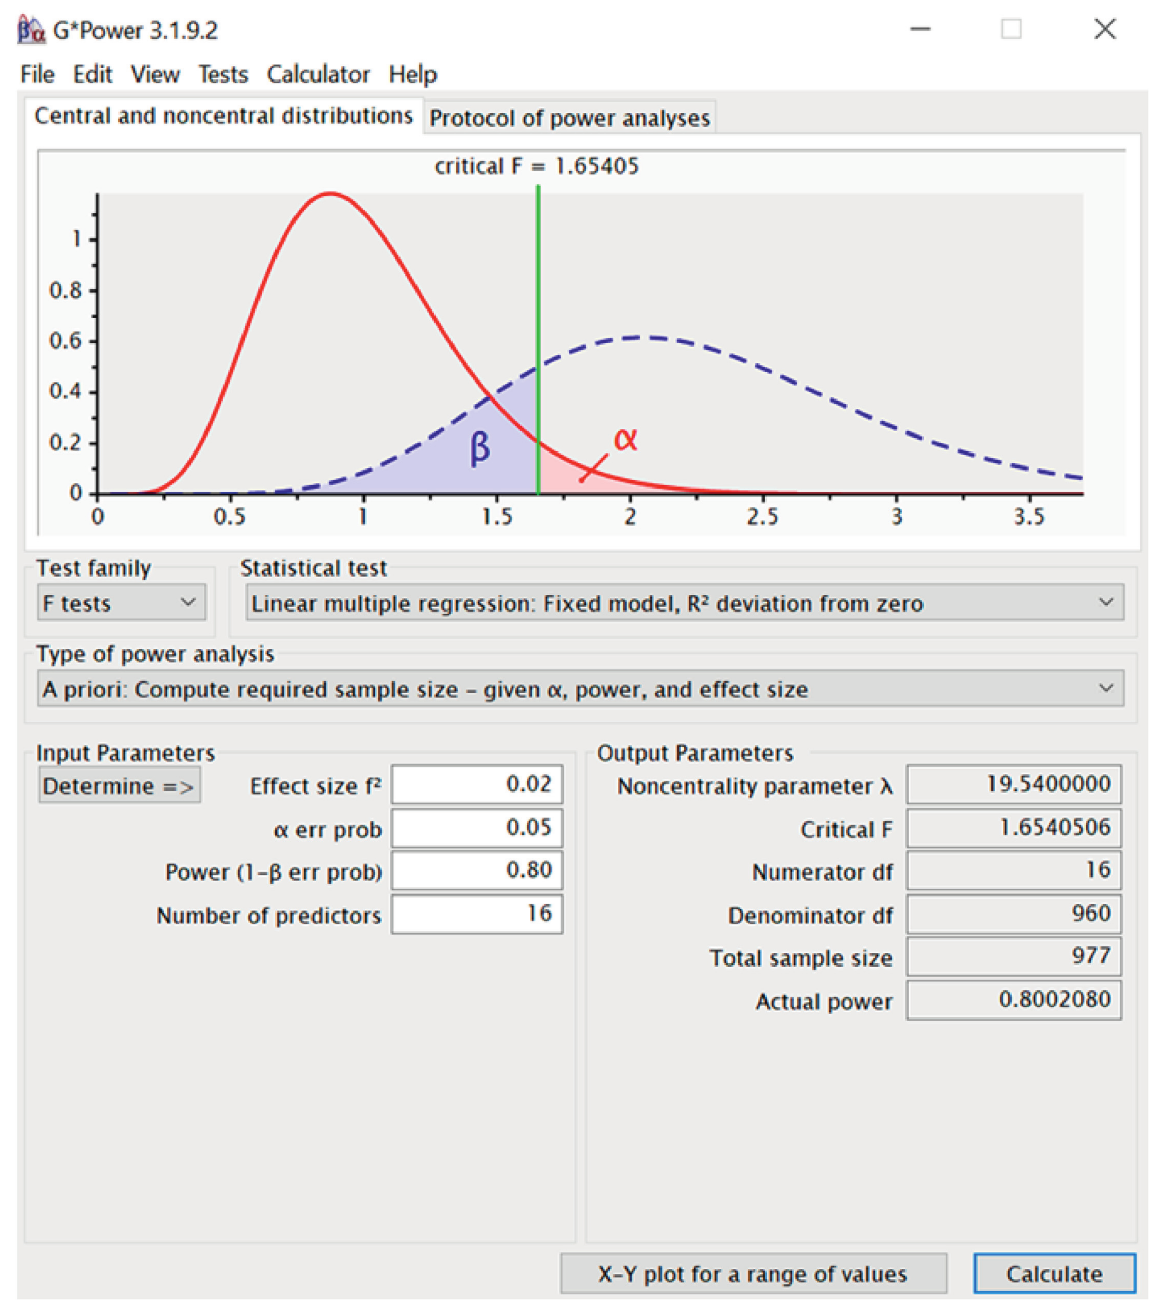
Figure 1: Sample size calculation using G ∗ power 3.1.9.2